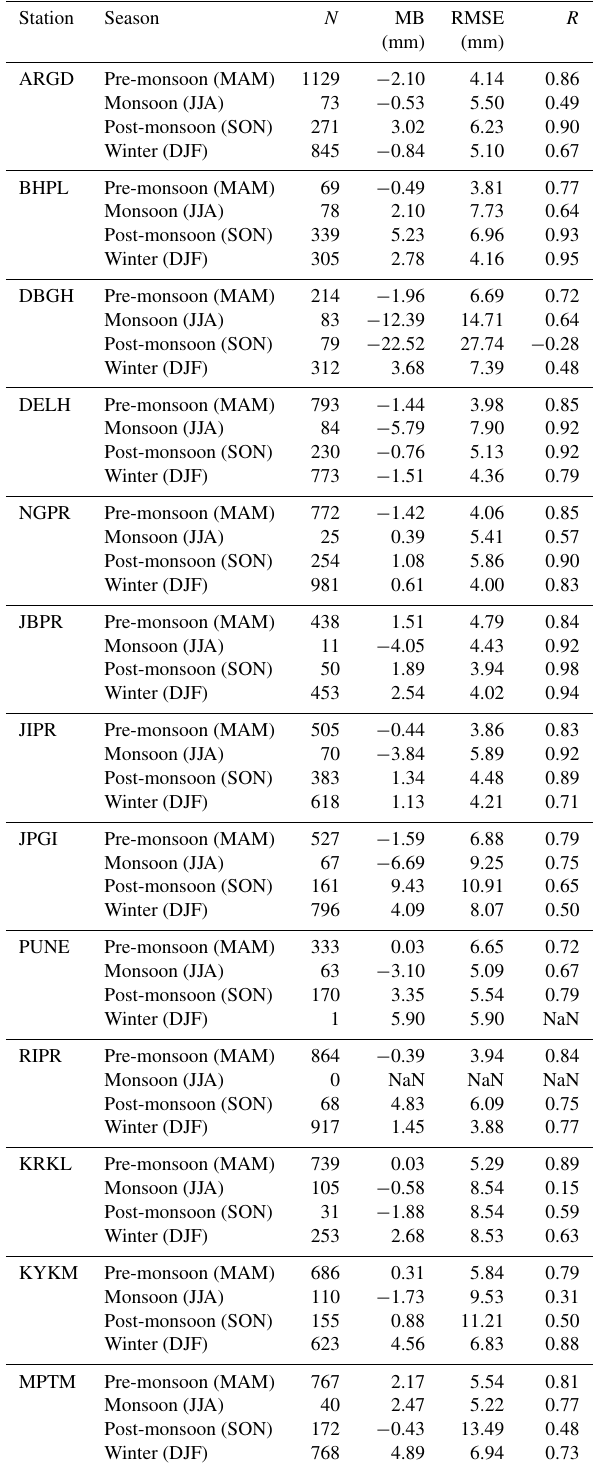
Table 4. Statistical seasonal analysis of retrievals of IPWV from INSAT-3DR and GNSS data. NaN indicates no availability of ob- servational data.